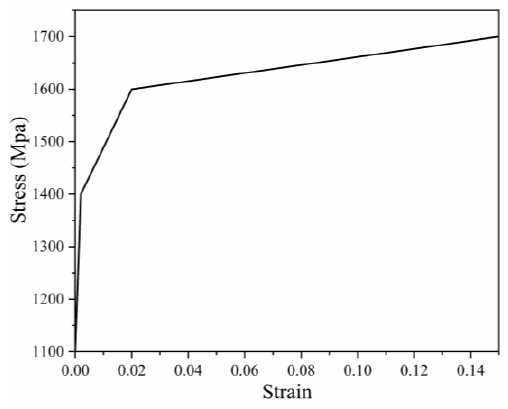
Figure 10. Stress – strain curve. Figure 10. Stress–strain curve.